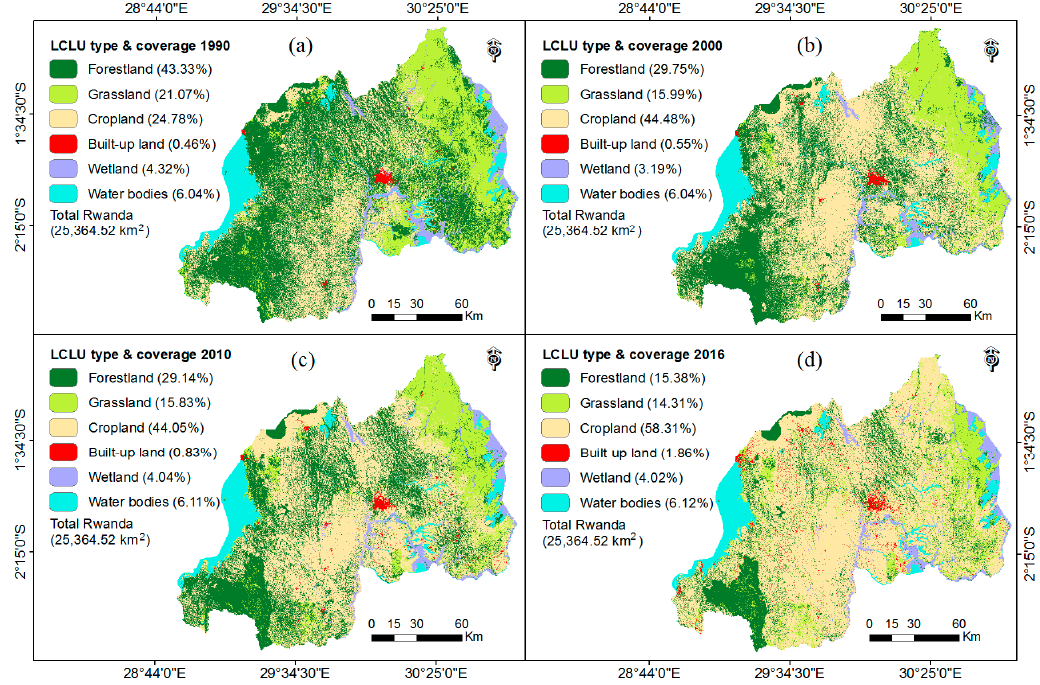
Figure 5. Land cover and land use maps of Rwanda for the periods: ( a ) 1990; ( b ) 2000; ( c ) 2010; and ( d ) 2016. Table 2. Error Matrix for land cover and land use map (Figure 5d) of Rwanda 2016.